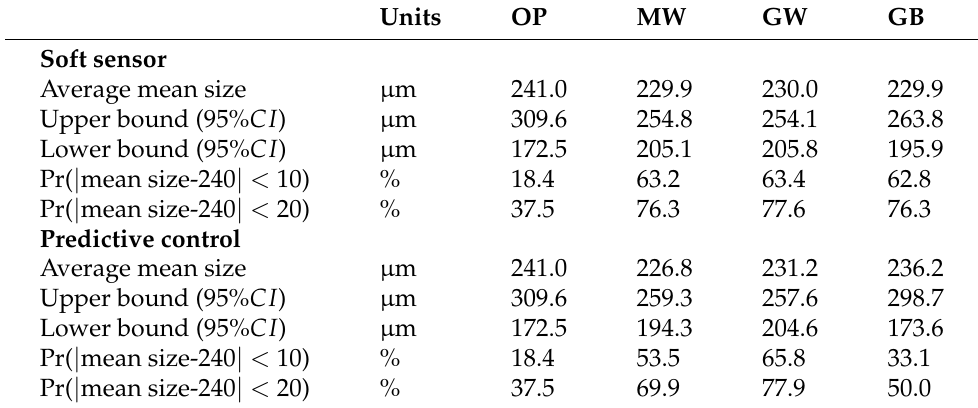
Table 4. Final results for the Monte Carlo RBF PI soft sensor and predictive control